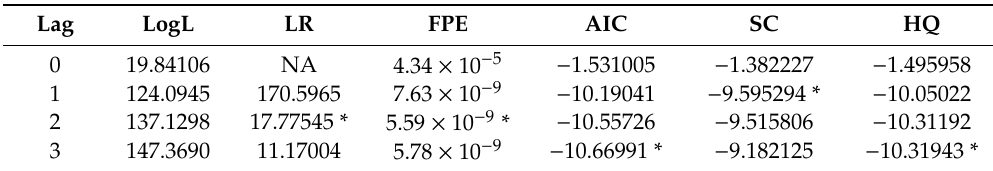
Table 6. VAR lag order selection criteria.